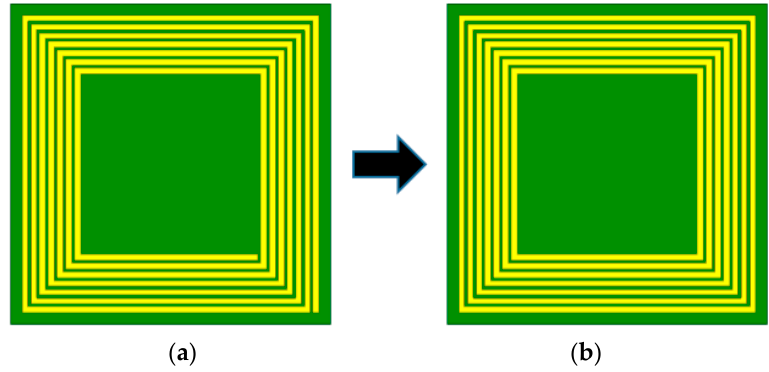
Figure 4. Equivalent model of printed spiral coils: ( a ) physical truth, ( b ) equivalent mode.